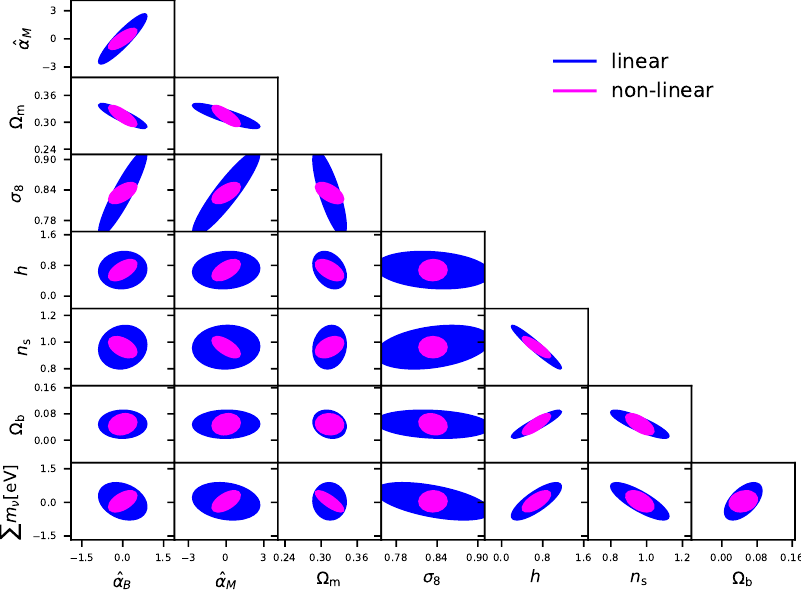
Figure 6. 68% confidence level contours on cosmological and MG parameters obtained by a Euclid - like survey cutting the nonlinear scales out of the analysis (blue) or including them (pink). This figure is taken from